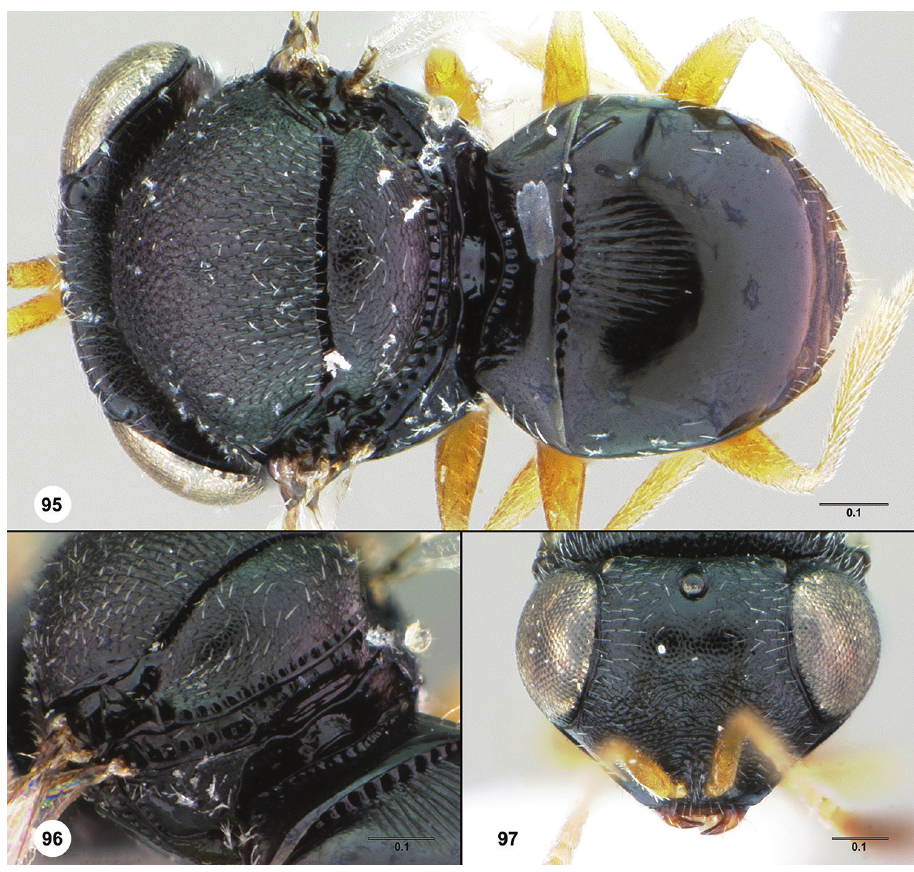
dorsal view 96 female (USNMENT00896174), mesosoma, posterolateral view 97 female (USN- MENT00896216), head, anterior view. Scale bars in